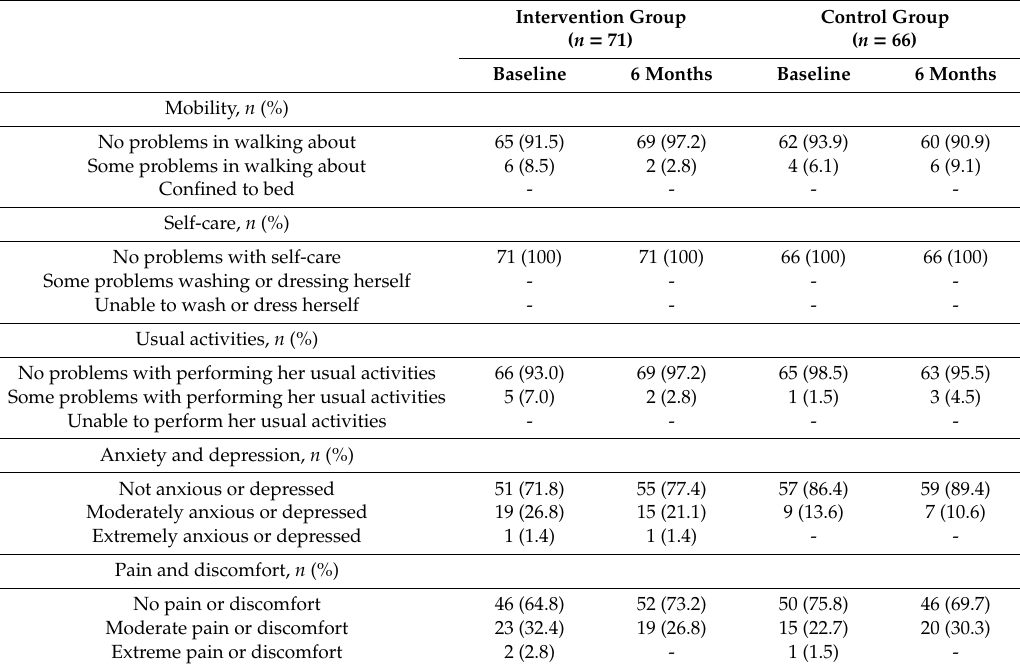
Table 2. EQ-5D-3L variables in postmenopausal women participants.